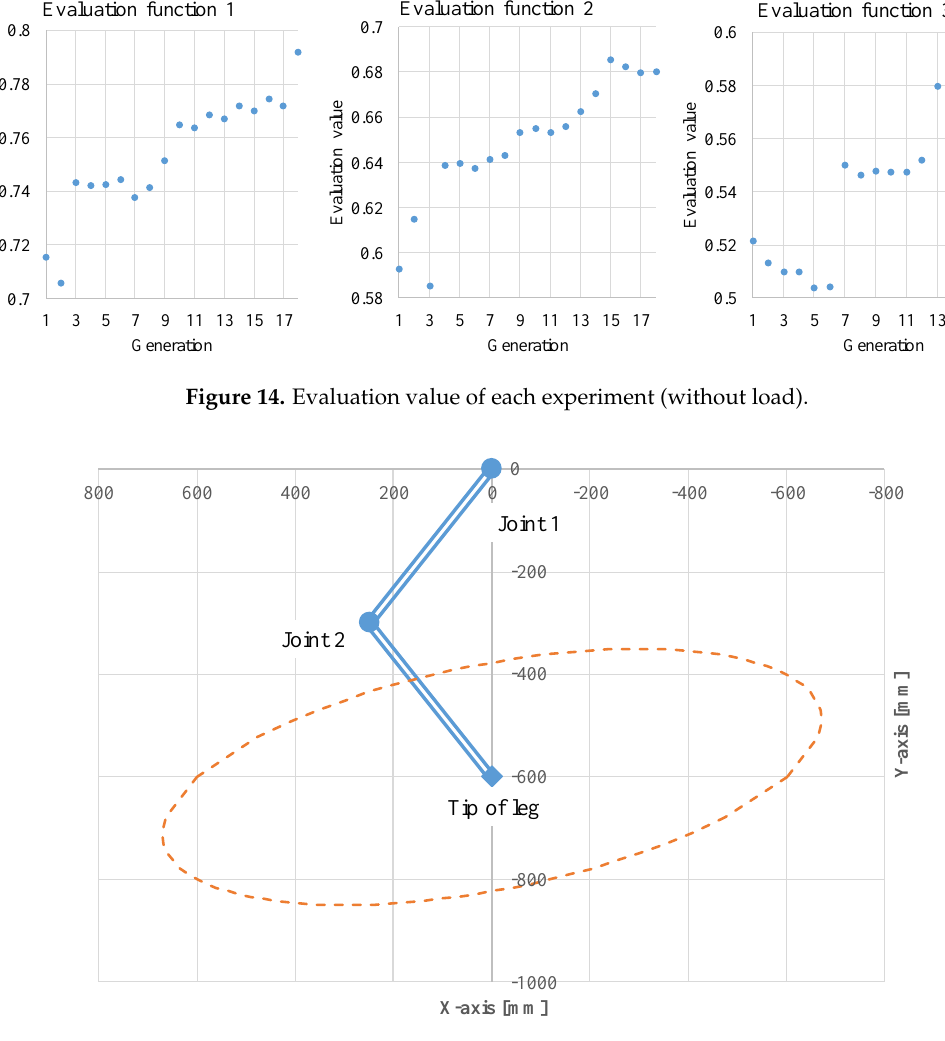
Figure 15. Manipulability ellipsoid of the leg around [0, −600].